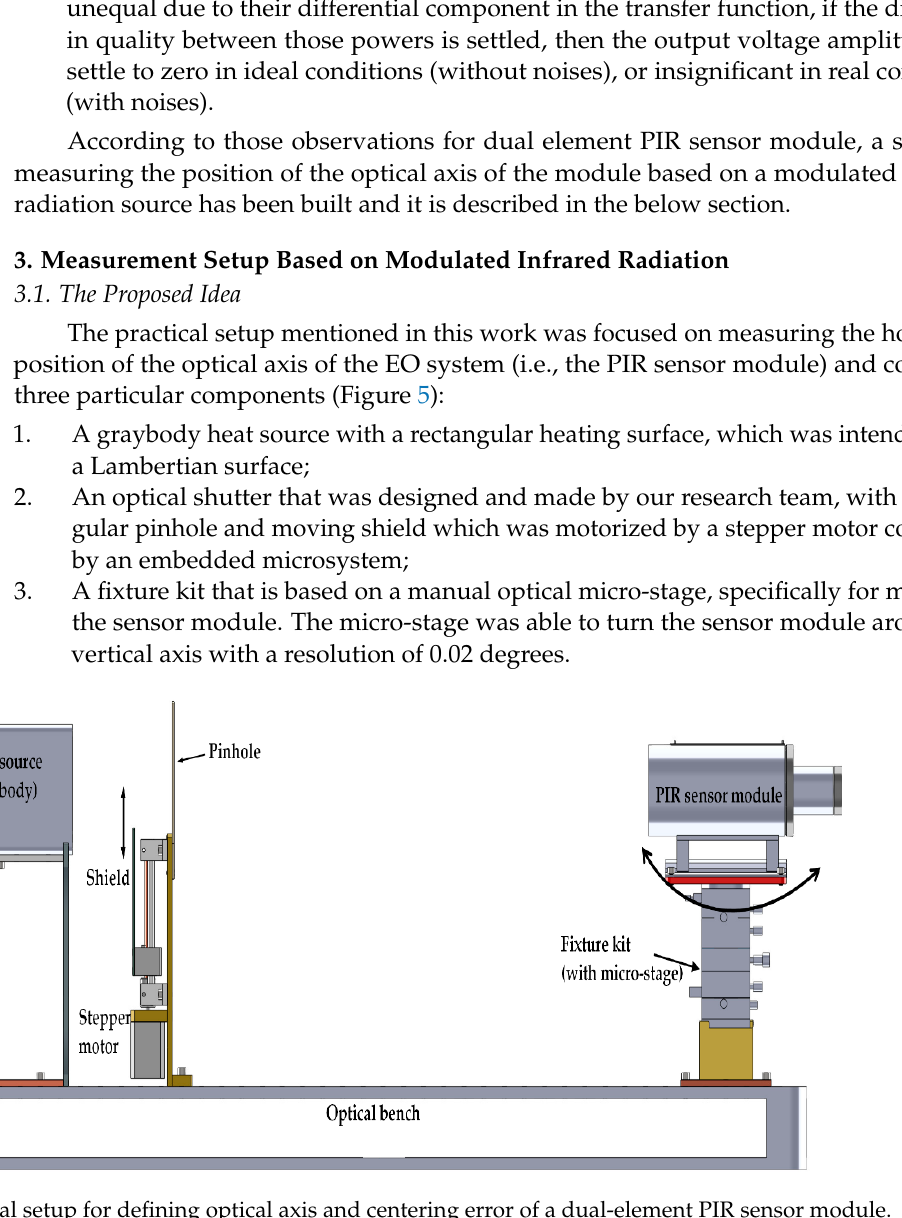
Figure 5. Experimental setup for defining optical axis and centering error of a dual ‐ element PIR sensor module .